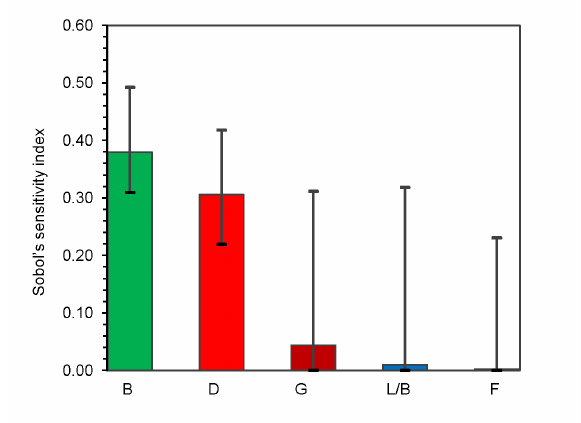
Fig. 10. Sensitive Analysis